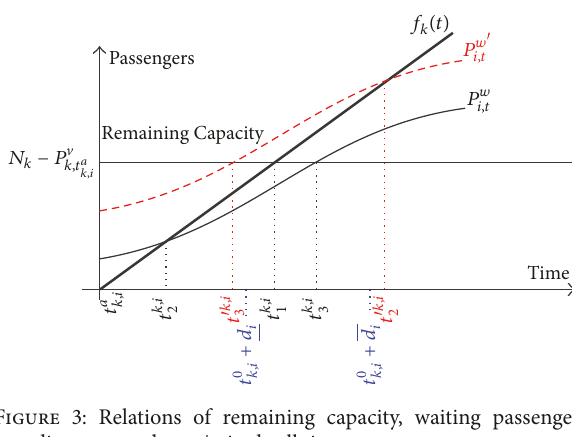
Figure 3: Relations of remaining capacity, waiting passengers, boarding rate, and max/min dwell